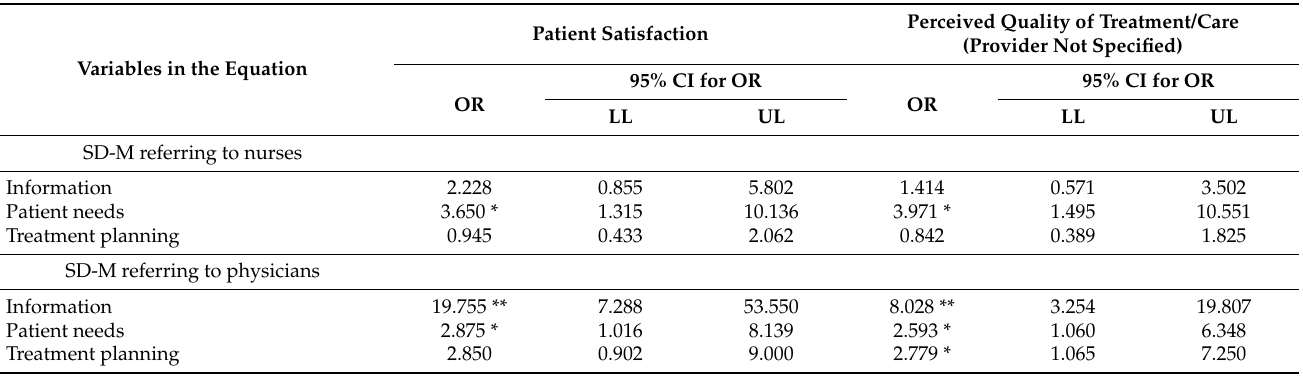
Table 4. Binary logistic regression results: relationship between shared decision-making variables and both patient satisfaction and perceived quality of